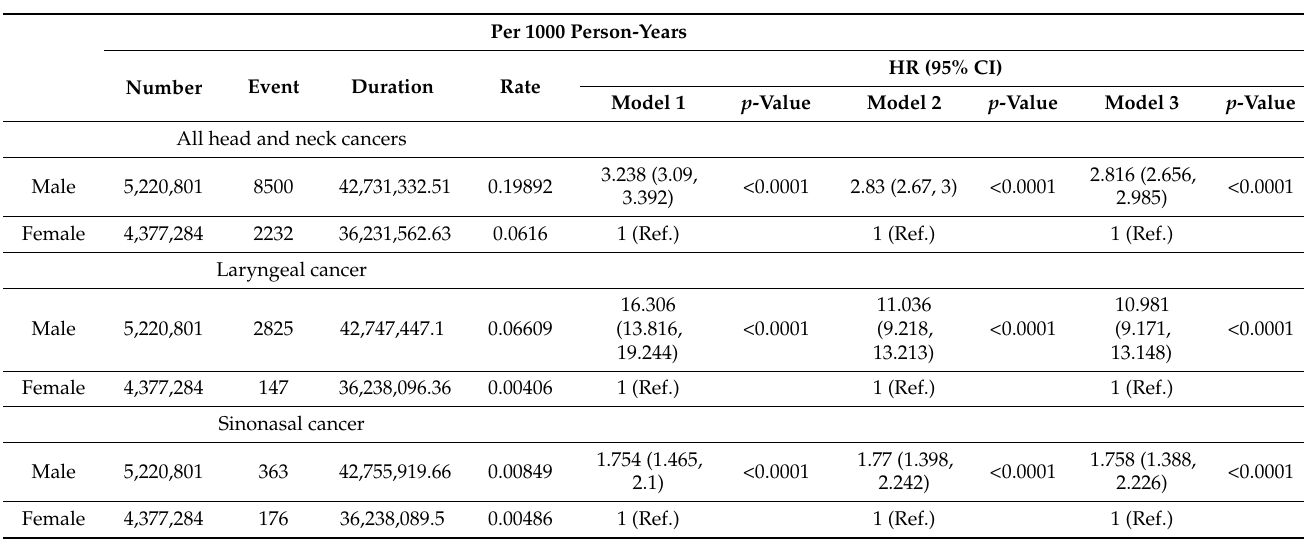
Table 2. Multivariate Cox’s proportional hazard model for the incidence of head and neck cancer by sex. Model 1: unadjusted. Model 2: adjusted for age, body mass index (BMI), low income, smoking status, drinking status, and regular exercise. Model 3: adjusted for age, body mass index (BMI), low income, smoking status, drinking status, regular exercise, and diabetes mellitus and hypertension